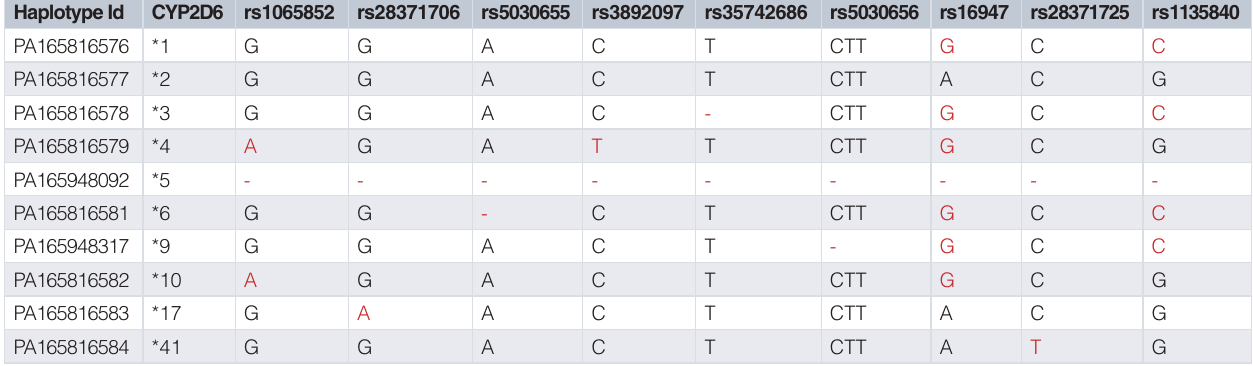
Table S2. Haplotype translation table for CYP2D6 .